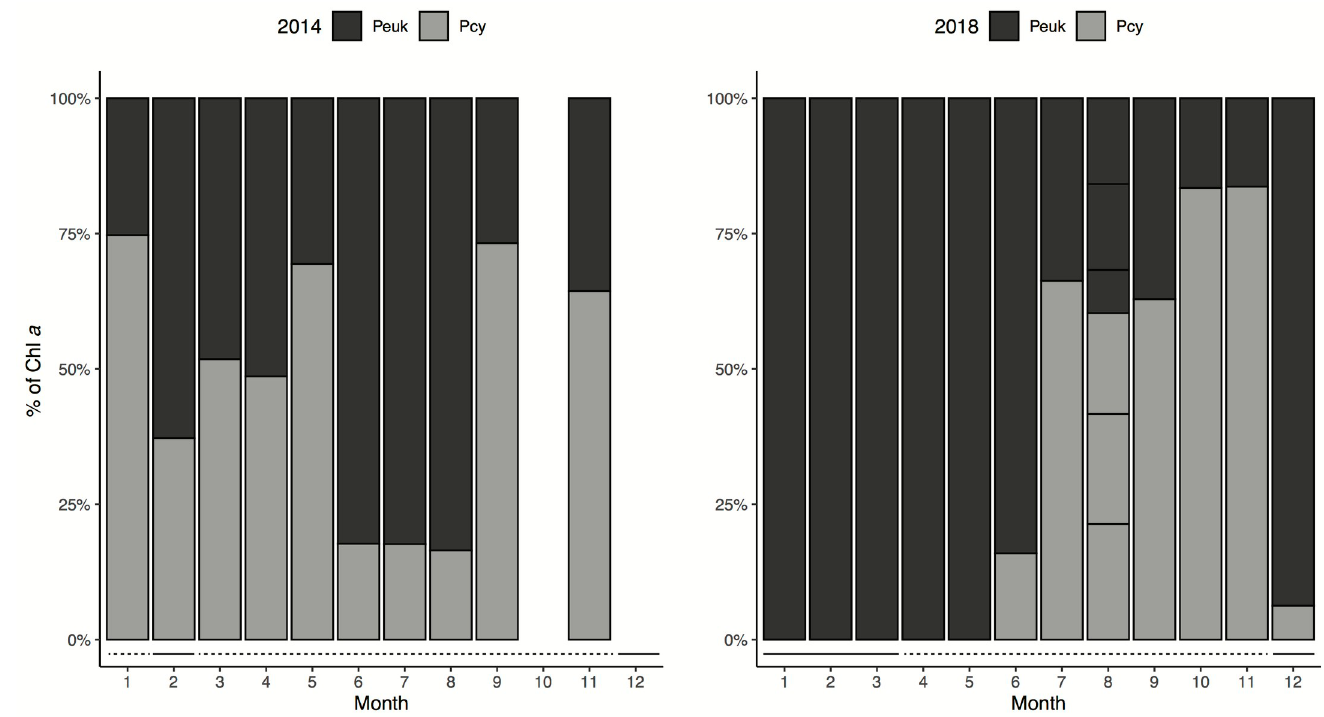
Fig 6. Relative contribution of phototrophic picoeukaryotes and picocyanobacteria in Lake V õ rtsja¨rv in 2014 (left) and 2018 (right). Solid line represents the months where samples were collected from under ice. Dashed line refers to months without ice cover during sampling.